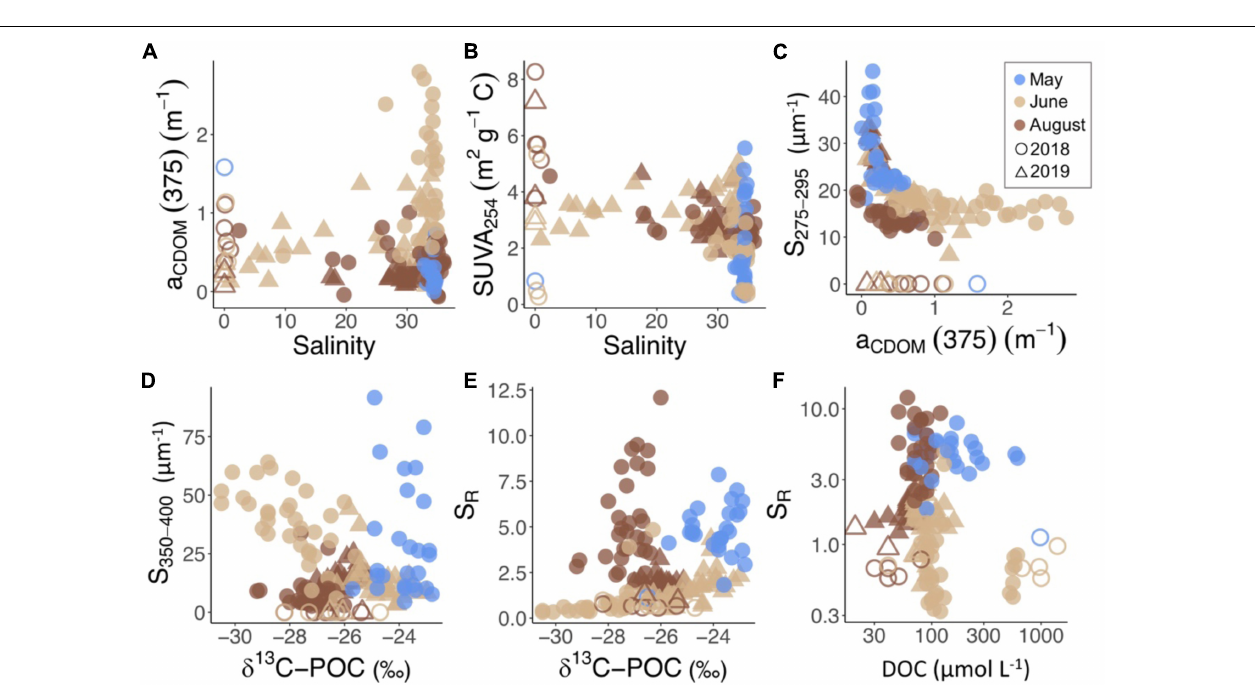
FIGURE 6 | cDOM absorption characteristics including (A) a CDOM (375) and (B) SUVA 254 vs. salinity, (C) S 275 - 295 vs. a CDOM (375) and (D) S 350 - 400 and (E) slope ratio (S R ) vs. δ 13 C-POC and (F) S R vs. DOC for all water samples by year (symbol) and month (color). River samples are further distinguished by open